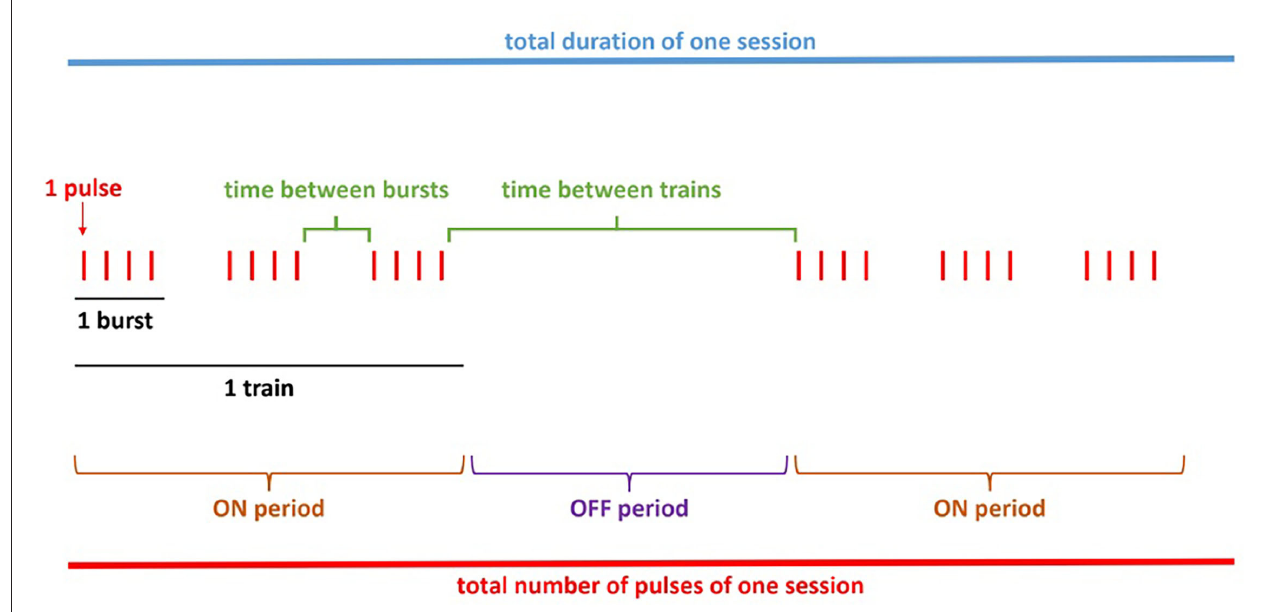
FIGURE 3 | Scheme example of an rPMS stimulation protocol included in the questionnaire. These details aim at avoiding any misunderstanding related to the terminology used.